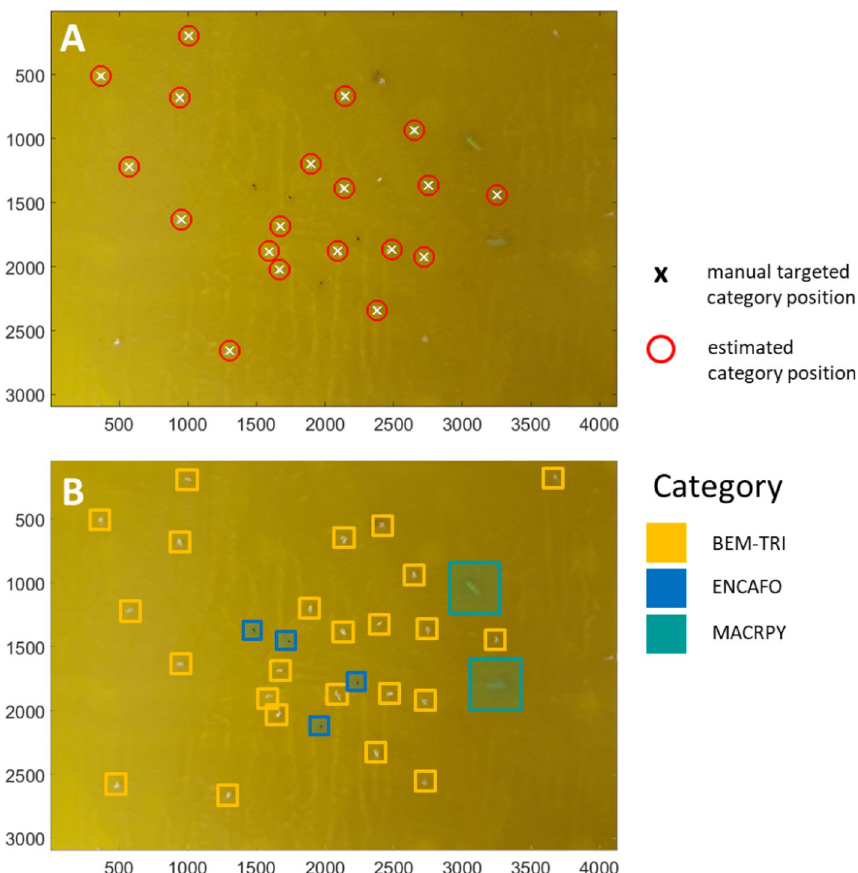
Figure 2. Results of spatial image classification on an image from GH0-7d dataset. ( A ) The crosses are the manually targeted positions of TRIAVA by category, and the red circles show the position of the category position estimated by the BoVW algorithm. Four additional BEMITA individuals were skipped. ( B ) Example of classification into categories BEM-TRI, ENCAFO and MACRPY. The four additional BEMITA individuals were correctly detected within the BEM-TRI category. For better clarity, the BKGRND category was excluded from the